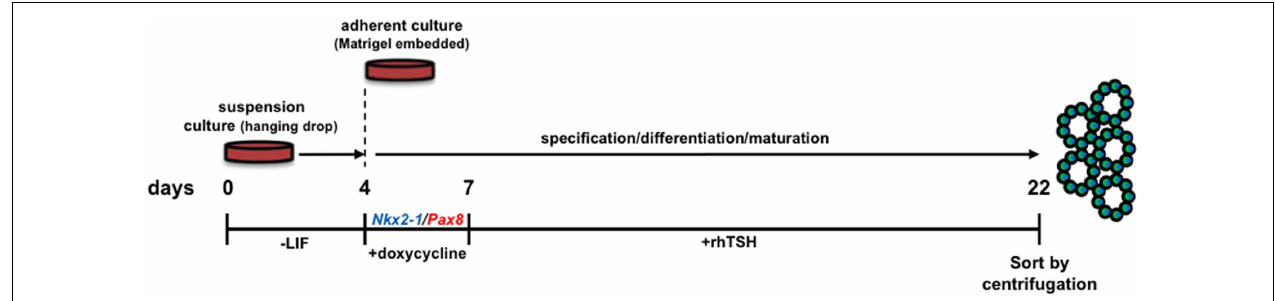
differentiation toward a thyrocyte fate. Forced expression of Nkx2-1/Pax8 results in robust thyroid stimulating hormone receptor expression, suggesting cells are capable of responding to rhTSH.Therefore, the sequential treatment of embryoid bodies with Dox-rhTSH dramatically enhances thyrocyte lineage specification and the formation of follicle-like structures, which are subsequently isolated for transplantation [Ref.